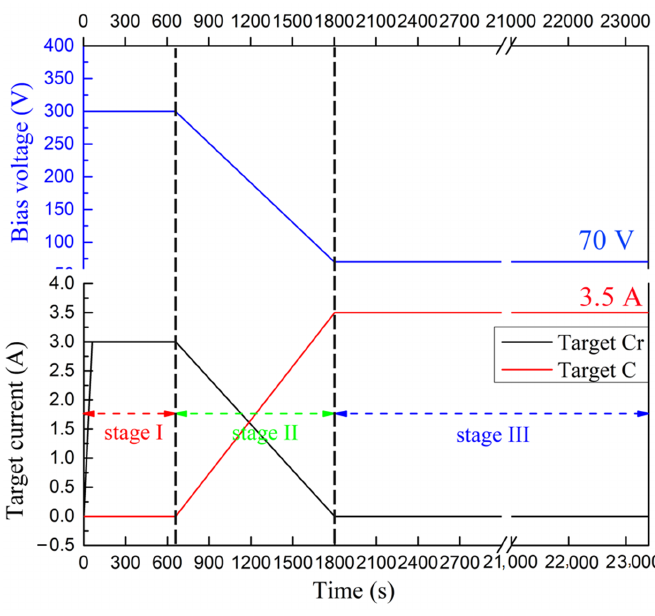
Figure 1. Schematic diagram of DLC coatings deposition